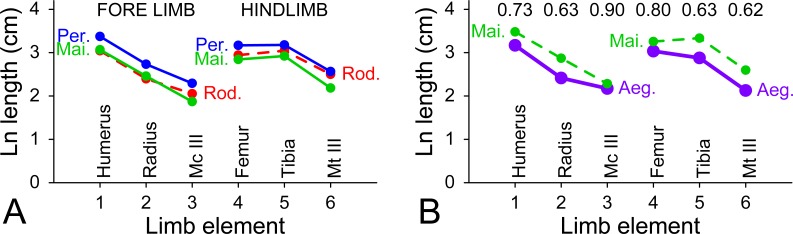
Forelimbs and hind limbs of the protocetids Rodhocetus balochistanensis (Rod.) [4], Maiacetus inuus (Mai.) [5], Peregocetus pacificus (Per.) [7], and Aegicetus gehennae (Aeg.) compared in terms of proportion.A, comparison of Rodhocetus, Maiacetus, and Peregocetus. Note the proportional similarity (parallel trajectories) of Maiacetus and Peregocetus. Rodhocetus has proportionally longer Mc III and Mt III than either Maiacetus or Peregocetus. B, comparison of Aegicetus to a hypothetical Maiacetus (or Peregocetus) of the same body weight (Maiacetus, dashed lines, was rescaled by adding the difference in ln values for the cube-roots of Aegicetus and Maiacetus body weights). Note that all elements of Aegicetus are smaller than expected if it were to be proportioned like Maiacetus (by proportions listed across the top of the panel: 0.73, 0.63, etc.). The radius, tibia, and Mt III lengths of Aegicetus are the most reduced, and Mc III length of Aegicetus is the least reduced.